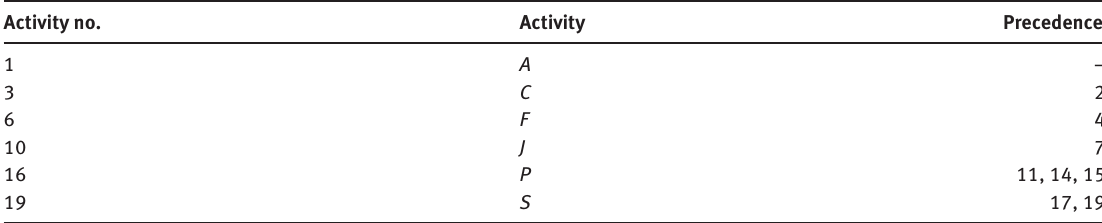
Table 2: Activities Precedence. Activity no. Activity Precedence